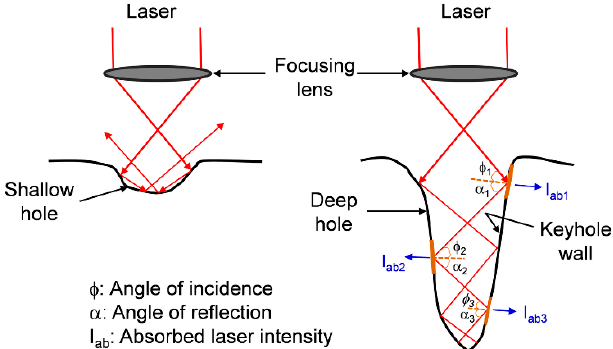
Figure 1. Schematic illustration of multi-reflections effect inside the keyhole.